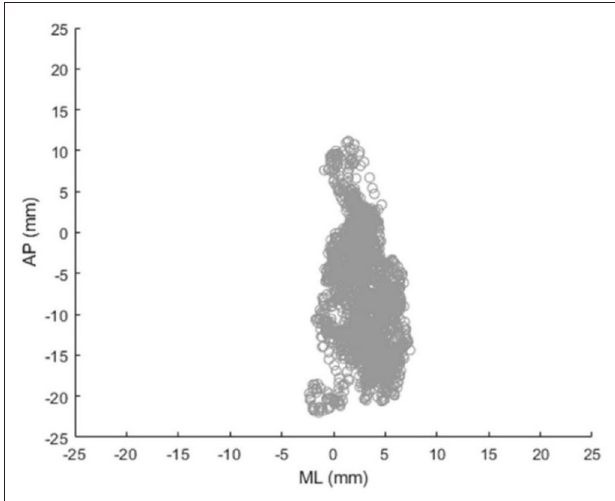
FIGURE 3 | Exemplary center-of-pressure (CoP) trajectory during static standing measured by Nintendo Wii Balance Board (AP, anterior-posterior; ML,